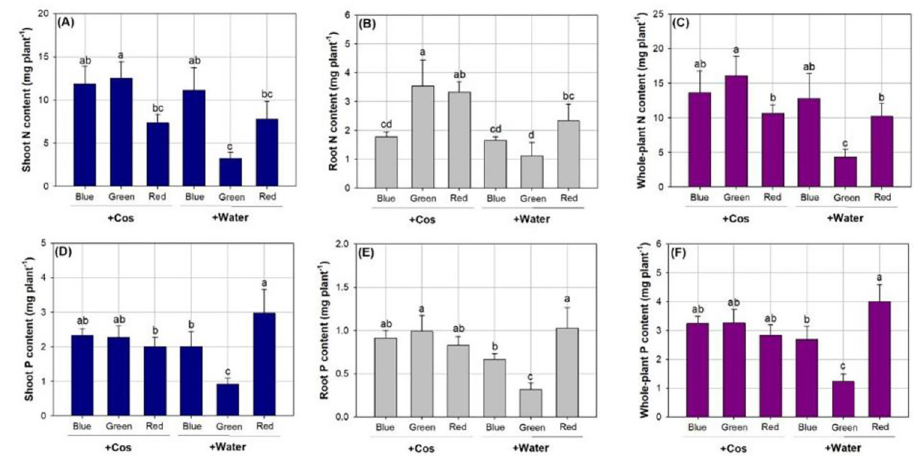
Fig 6. Contents of nitrogen (N) (A, B, and C) and phosphorus (P) (D, E, and F) in shoot (left), root (middle), and whole plant (right) in Podocarpus macrophyllus seedlings exposed to chitosan oligosaccharide (+Cos) or water (+Water) sprays in three types of light-emitting diodes spectra from red, green, and blue lights. Bar height corresponds to the mean of the measurement while the error bars represent standard errors. Different letters represent difference at significant level of 0.05 by Tukey test.